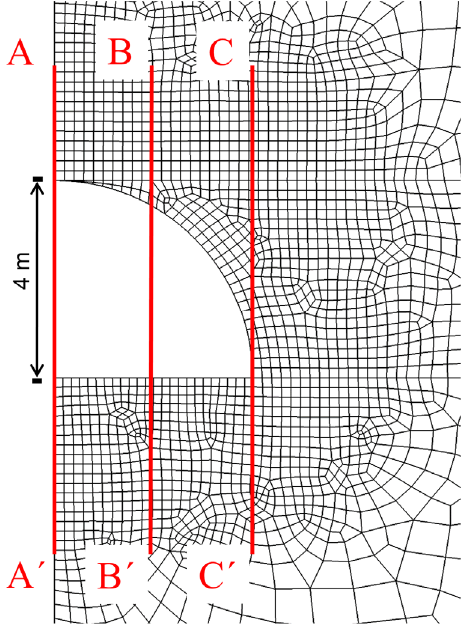
Figure 4. Position of the total displacement profiles in the 2D